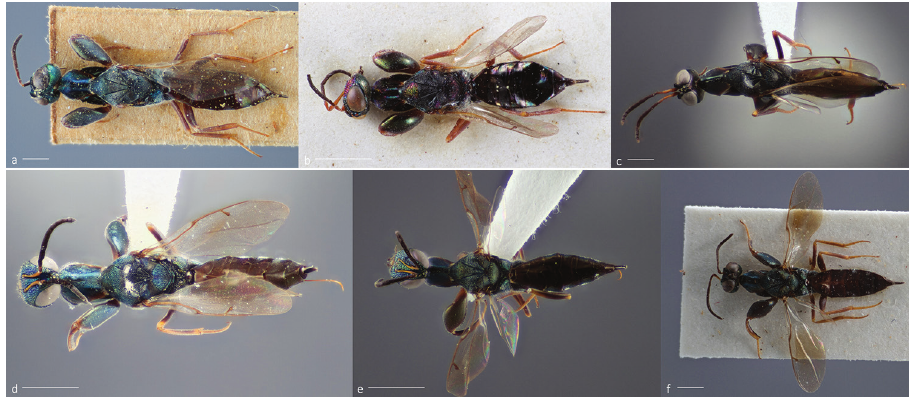
Figure 2. Habitus (dorsal) I a O. ahoma (Mani & Kaul) (imaged specimen: OAh01, holotype) b O. circularicollis sp. n. (OCi01, holotype), c O. felix sp. n. (OFe01, holotype) d O. fidelis sp. n. (OFi01, holotype) e O. florea sp. n. (OFl01, holotype) f O. formosa (Giraud) (OFo13). Scale bars: 1 mm.